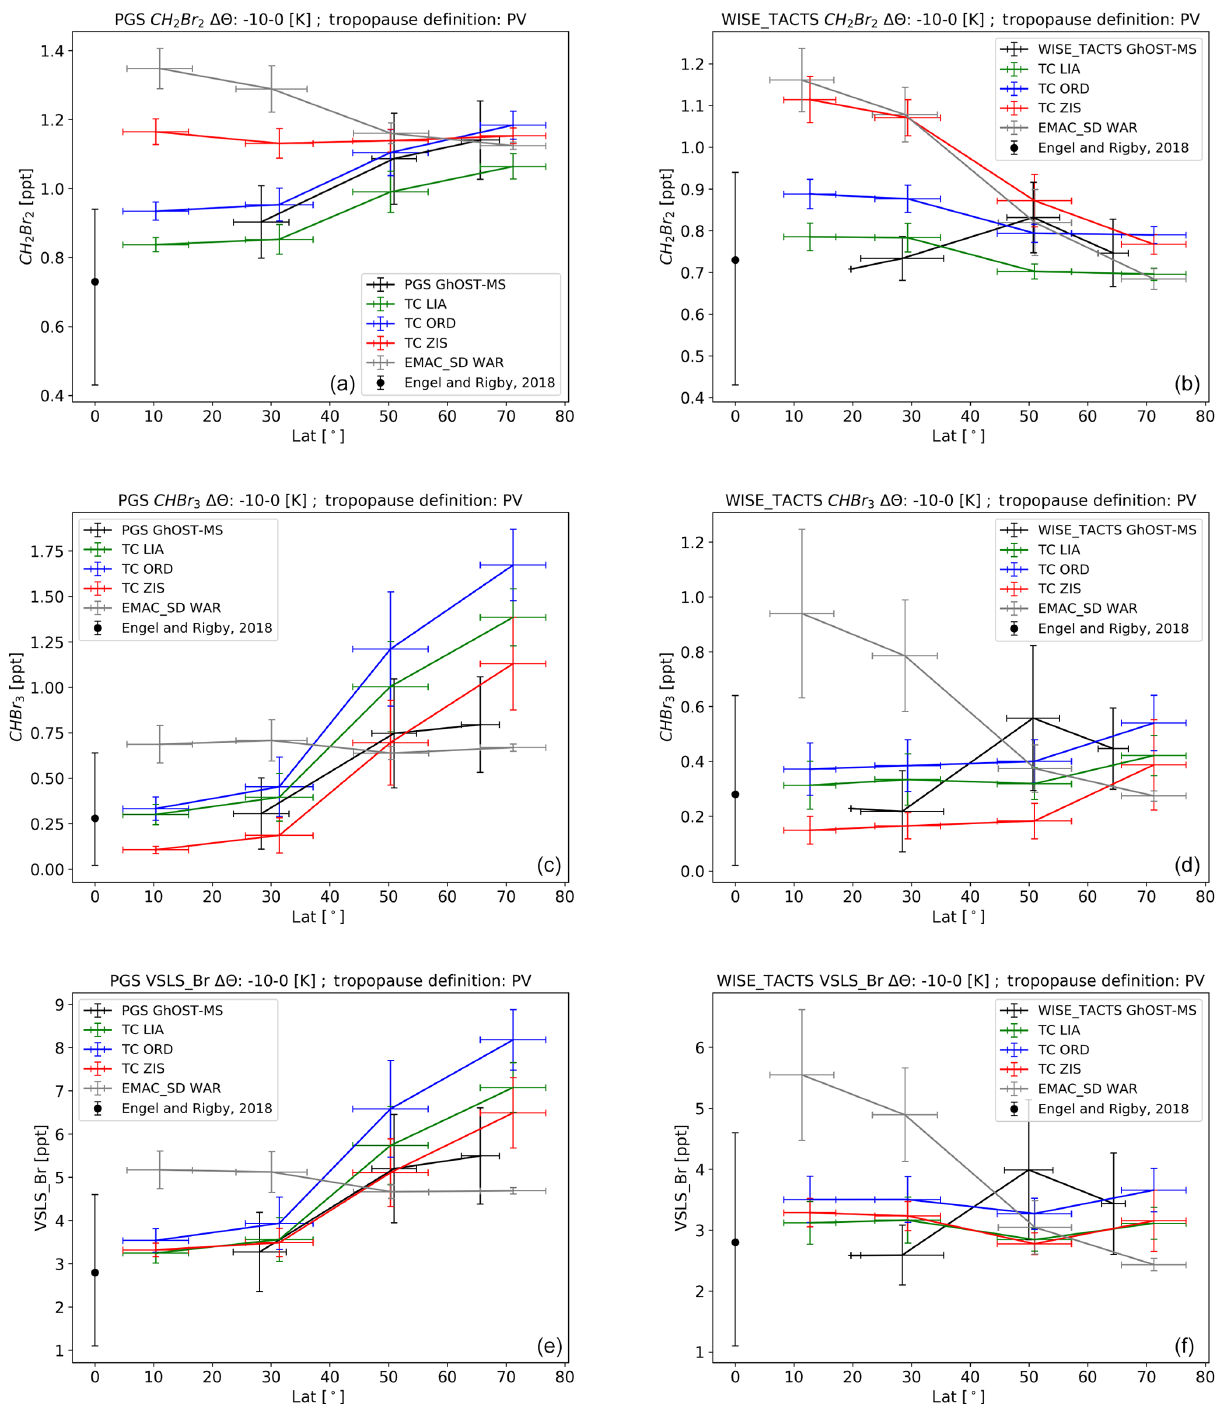
Figure 13. Latitude cross section of tropopause representative mixing ratios of CH 2 Br 2 (a, b) CHBr 3 (c, d) and total organic VSLS bromine (a, b) for all the measurements from the PGS campaign (a, c, e) and WISE_TACTS dataset (b, d, f) from observations in com- parison to all model emissions scenario combinations. Data are binned by latitude and averaged over 10K below the tropopause. Due to the different sampling of the observations and the models, the centres of the different latitude bins are not the same for observations and